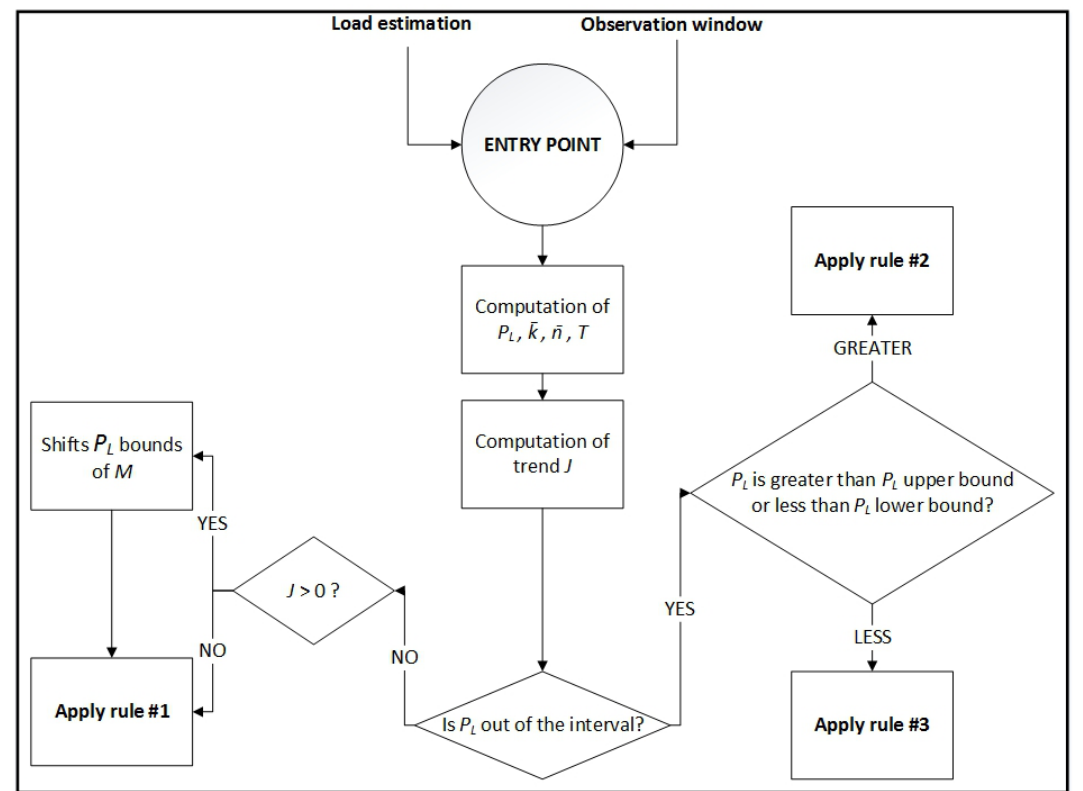
Figure 2. Load Control Algorithm flowchart - the rules are detailed in Algorithm